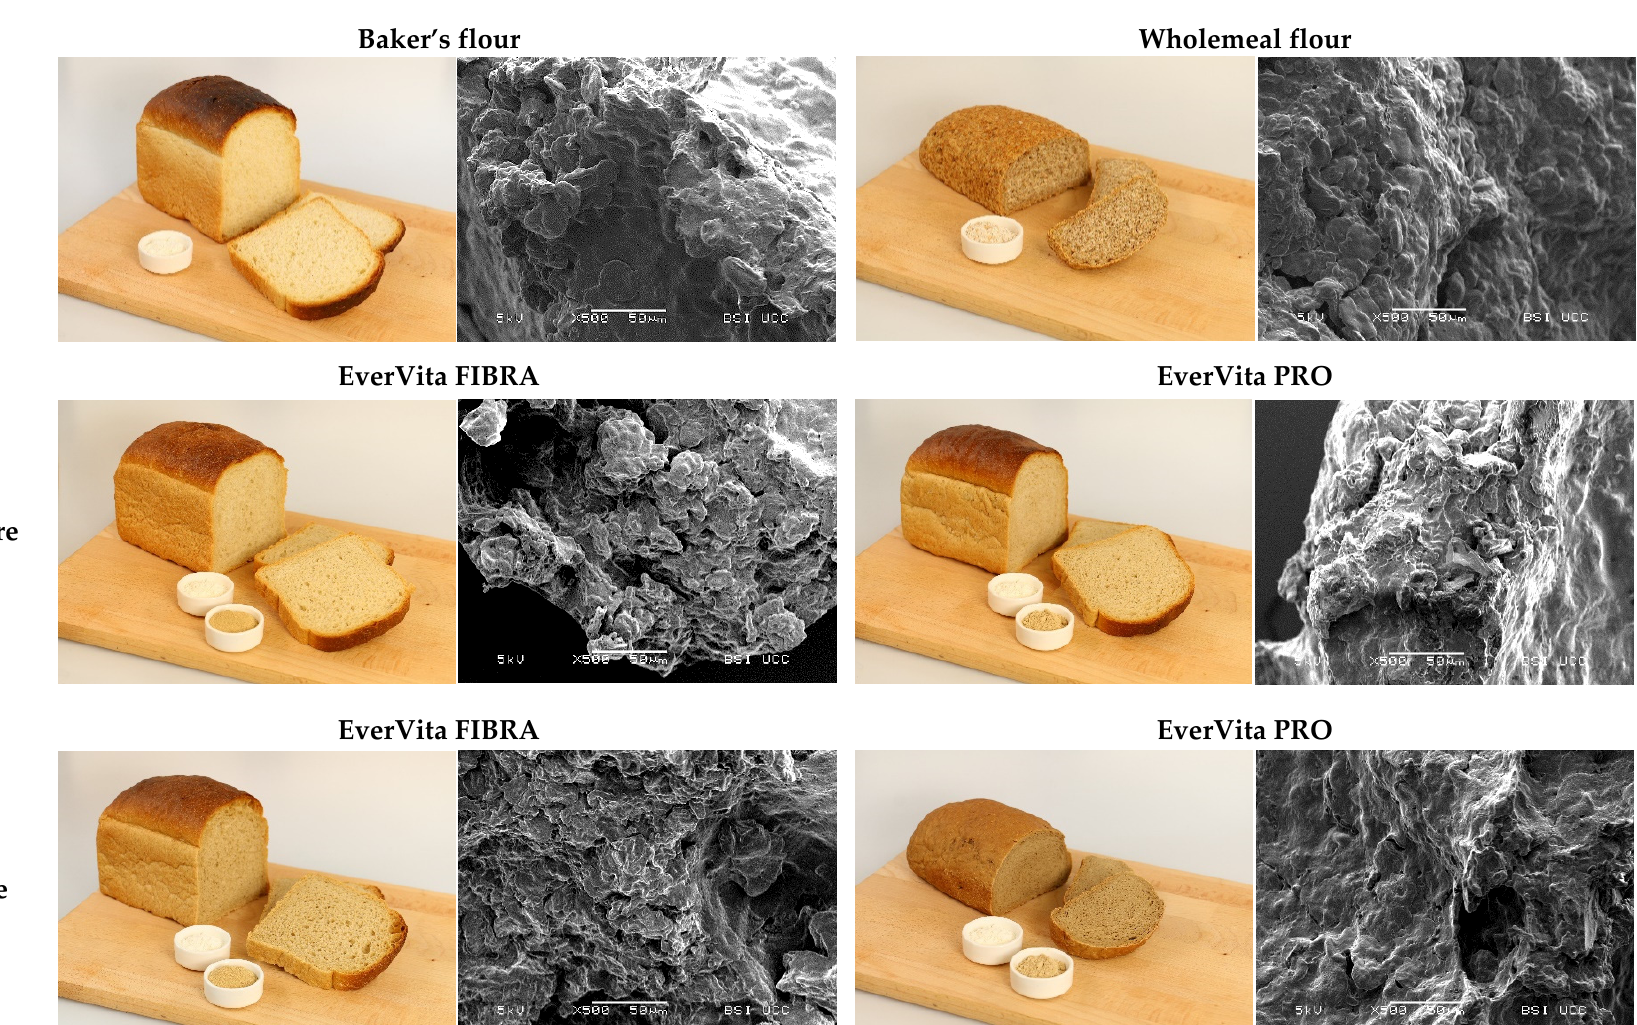
Figure 5. Appearance of fresh bread samples and micrographs of the bread crumbs. The first row illustrates the controls, baker’s flour and wholemeal flour; Breads including EverVita FIBRA and EverVita PRO in source of fibre level and in high in fibre level are demonstrated in the second and third row, respectively.